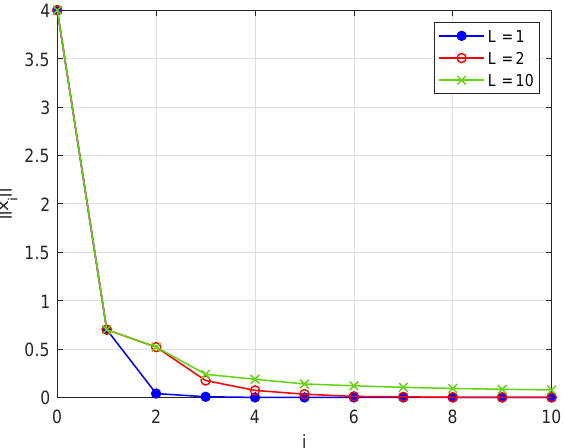
Figure 2. The state vector norms of the DDFL system (1), (93) with α = 0.4 and the SSF (60), (102) for x 0 = [ 1 4 − 2 ] and different values of L